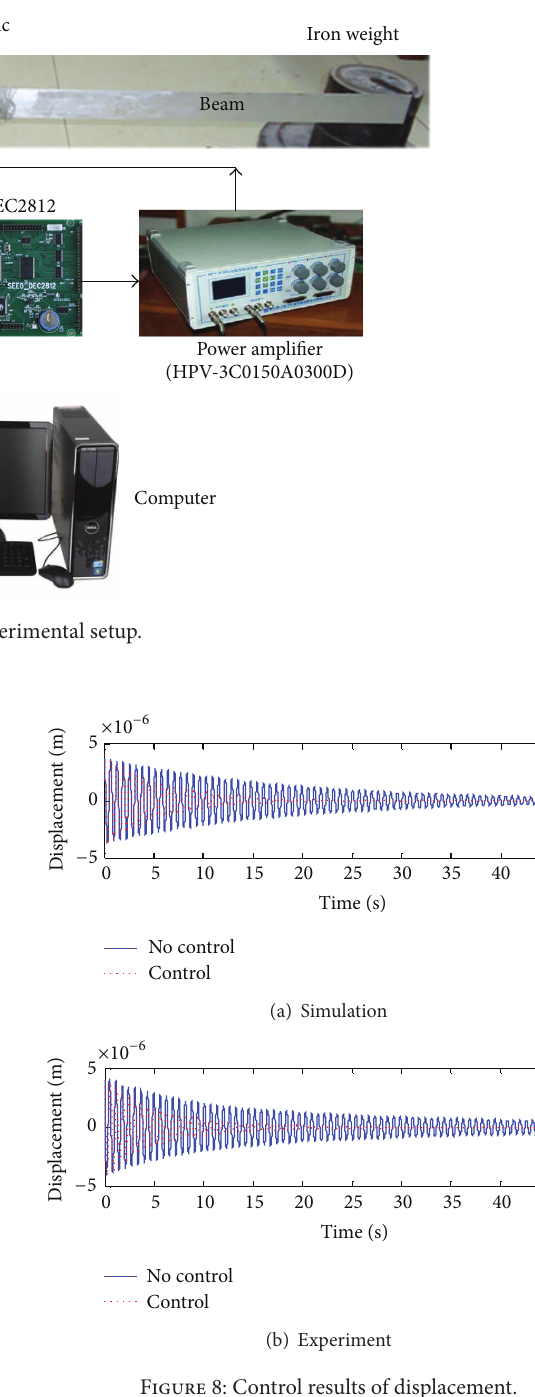
Figure 8: Control results of displacement.